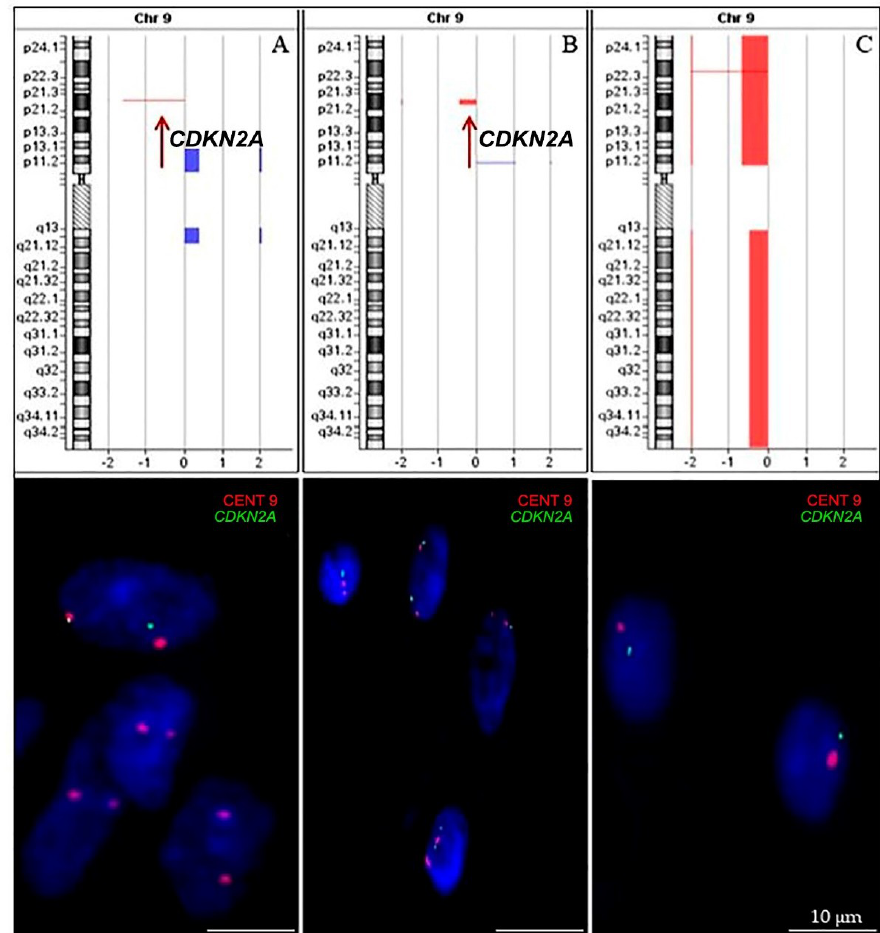
Figure 6. CDKN2A allelic loss identified by array-CGH (upper line) was confirmed by iFISH using LSPs (lower line). Results for three exemplary cases are shown: Image ( A ) shows homozygous deletion of CDKN2A gene; image ( B ) shows heterozygous deletion of CDKN2A gene; image ( C ) shows monosomy of chromosome 9. Scale bars = 10 μm. Int. J. Mol. Sci. 2019 , 20 , x FOR PEER REVIEW